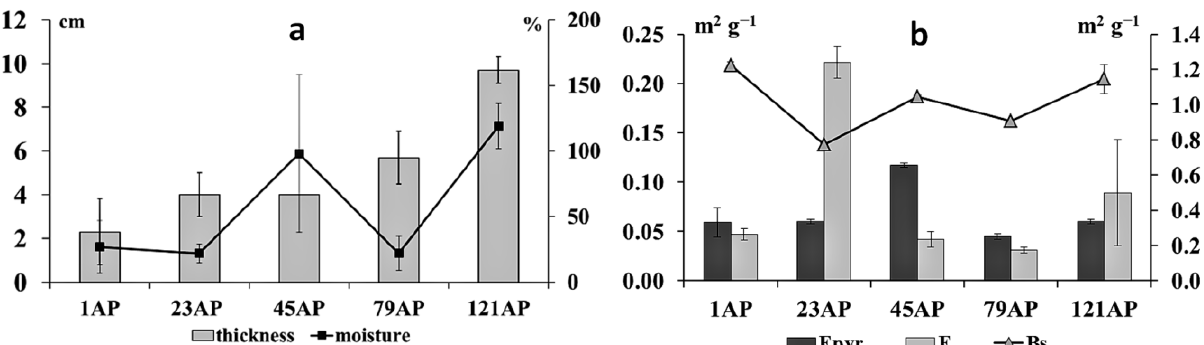
Figure 2. The thickness (left axis) and moisture content (right axis) of the organic horizons in the study soils ( a ). Specific surface area ( b ) of upper horizons ’ studied soils. E and E pyr on the left axis; study soils ( a ). Specific surface area ( b ) of upper horizons’ studied soils. E and E pyr on the left axis; organic layer and Bs on the right axis. organic layer and Bs on the right